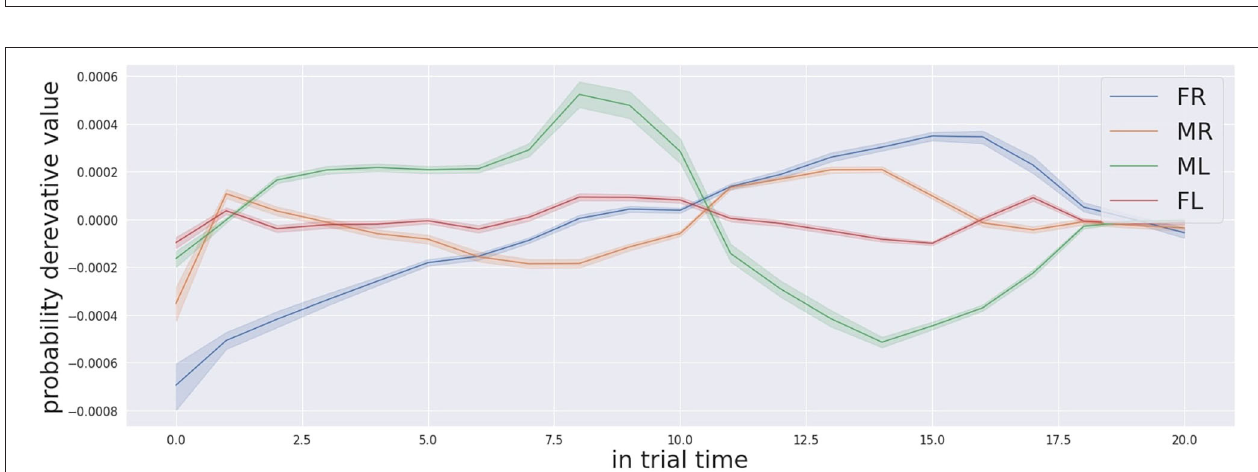
FIGURE 11 | Derivative of the audio probabilities profile for the trials that the far left box (FL in red colour) was activated.